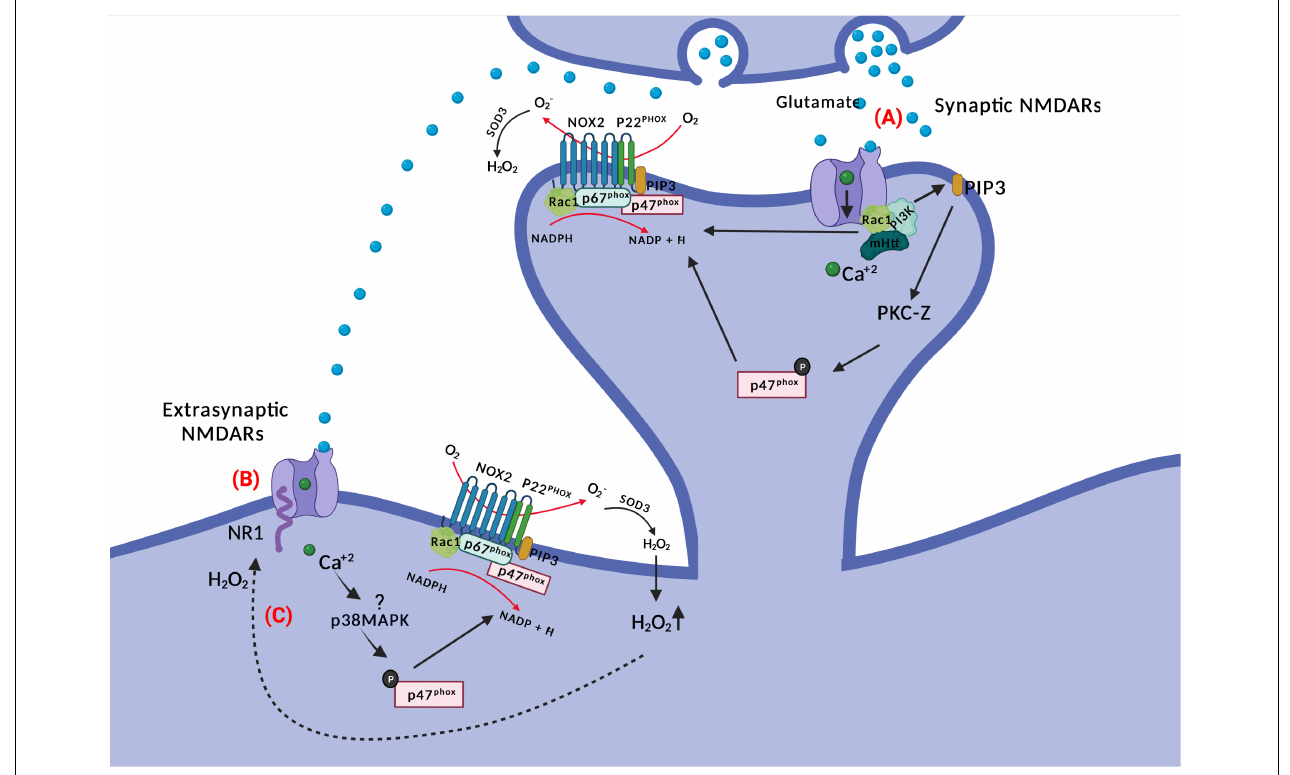
FIGURE 3 | NOX and NMDAR signaling. (A) Glutamate binding to NMDARs activates PI3K non-ionotropically (through conformational changes in the receptor) and subsequent PIP3 production. PIP3 activates PKC-zeta, which phosphorylates p47 phox . The latter translocates to the membrane for NOX2 complex assembly. There is also a requirement for Ca 2 + for NMDAR-mediated NOX2 activation; potentially through Rac1. (B) Glutamate spillover can activate extra-synaptic NMDARs, where activated p38MAPK may phosphorylate p47 phox inducing ROS production by NOX2. Extrasynaptic NMDARs activation is associated with neuronal death in HD. (C) NR1 subunits of NMDARs are redox targets of hydrogen peroxide, which alters their function and